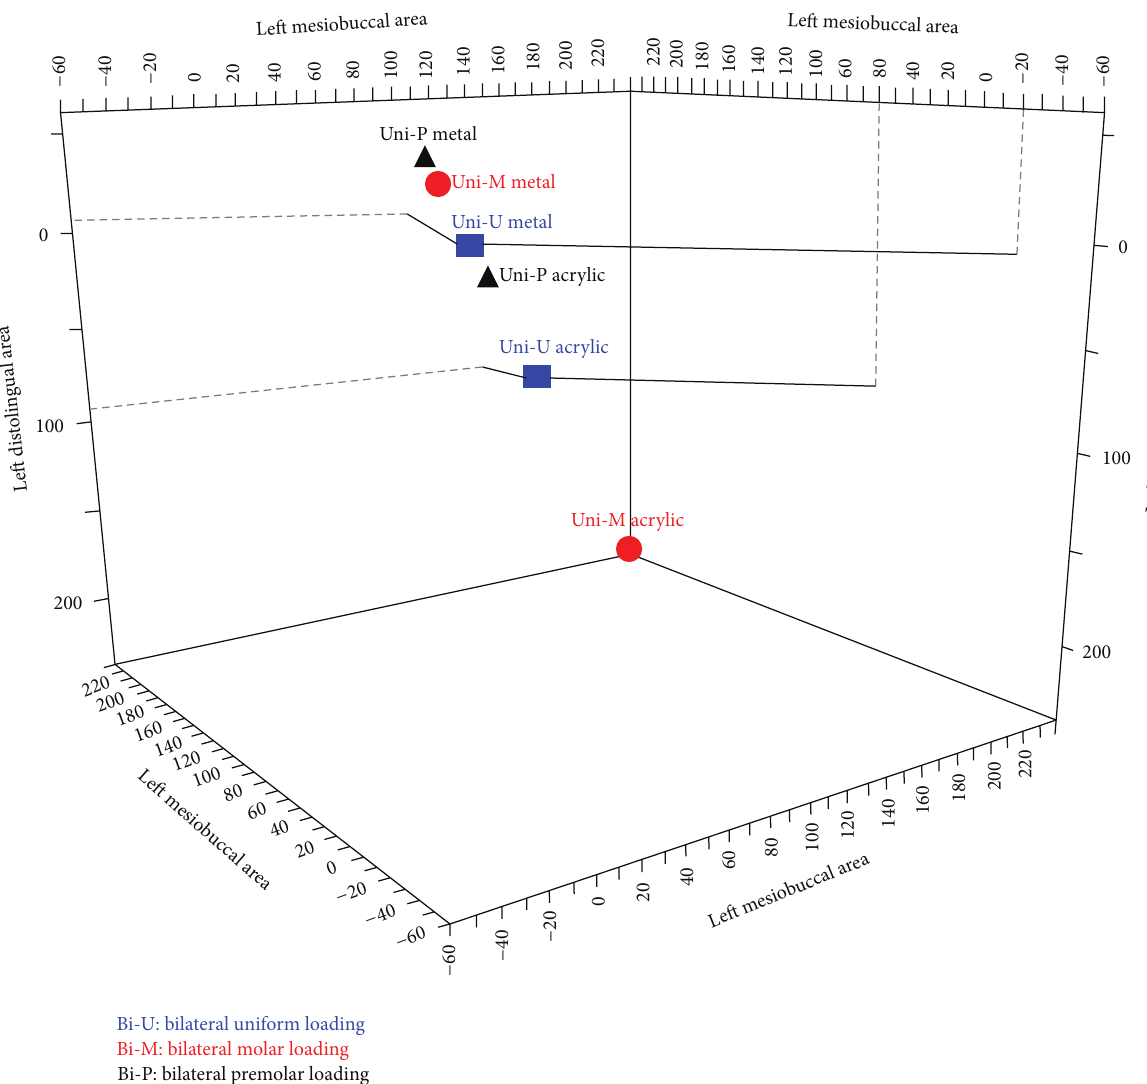
structures. This strain pattern is typical of a beam structure, with forces inwardly directed relative to the implant and occlusal rest. The IARPD acts like a typical beam due to the implant and occlusal rest restraining it from